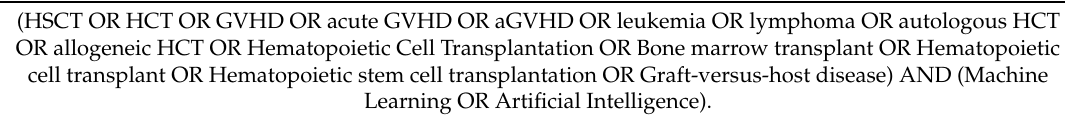
Table 1. Search query for the retrieval of